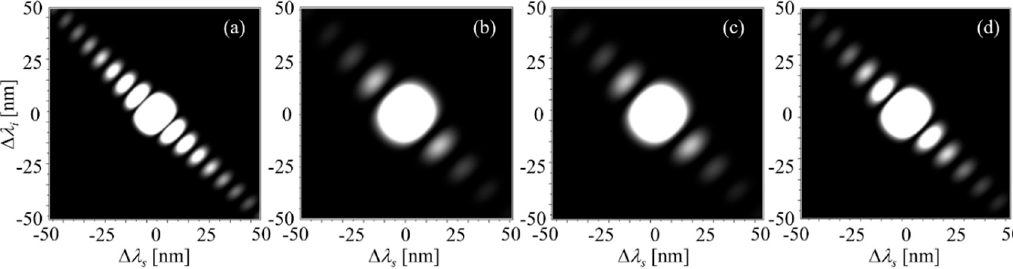
Figure 7. JSIs of Type II SPDC in non-poled ( a ) RTP, ( b ) RTA, ( c ) KTA, and ( d ) CTA with maximum d eff values (Table 3). The calculated purities are 0.997, 0.995, 0.995, and 0.995, respectively.